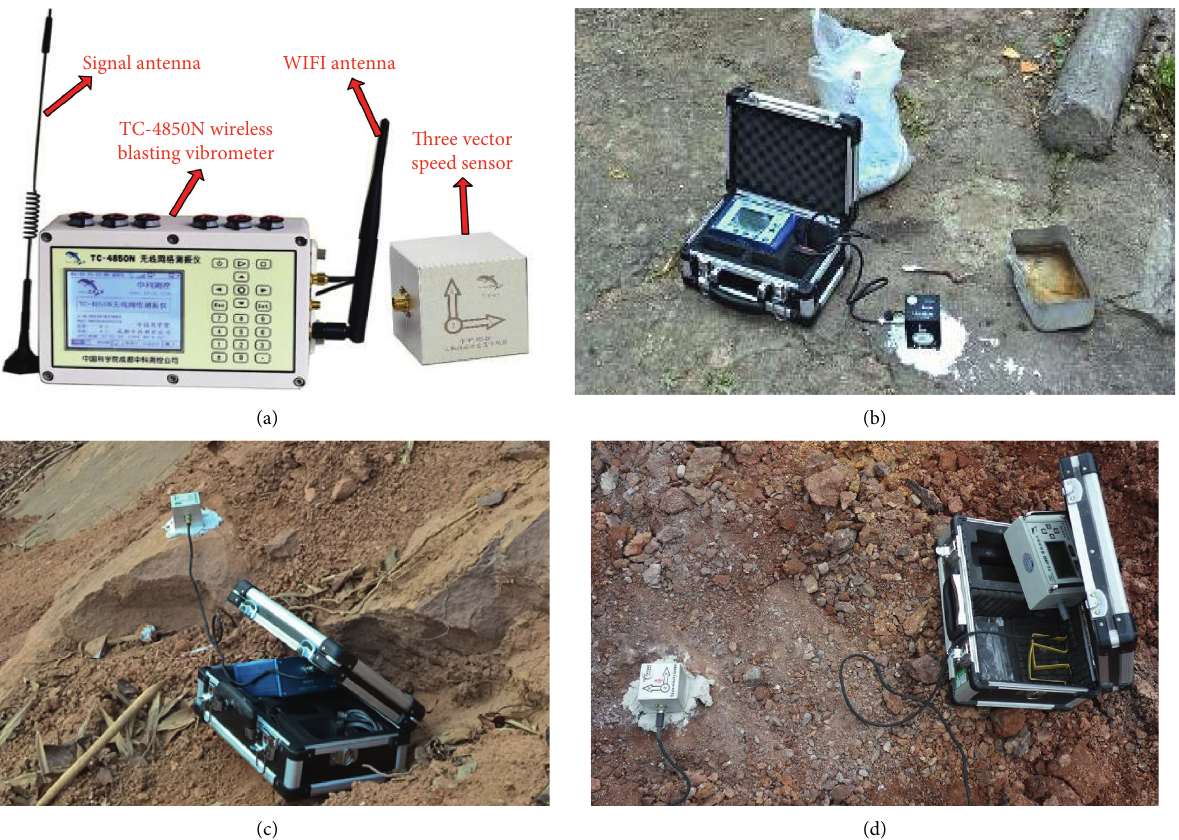
Figure 4: Blasting monitoring chart. (a) TC-4850N blasting monitor. (b) Vibration speed monitoring near high-rise residential buildings. (c) Vibration speed monitoring of adjacent engineering slopes. (d) Vibration speed monitoring of ground around the foundation pit.